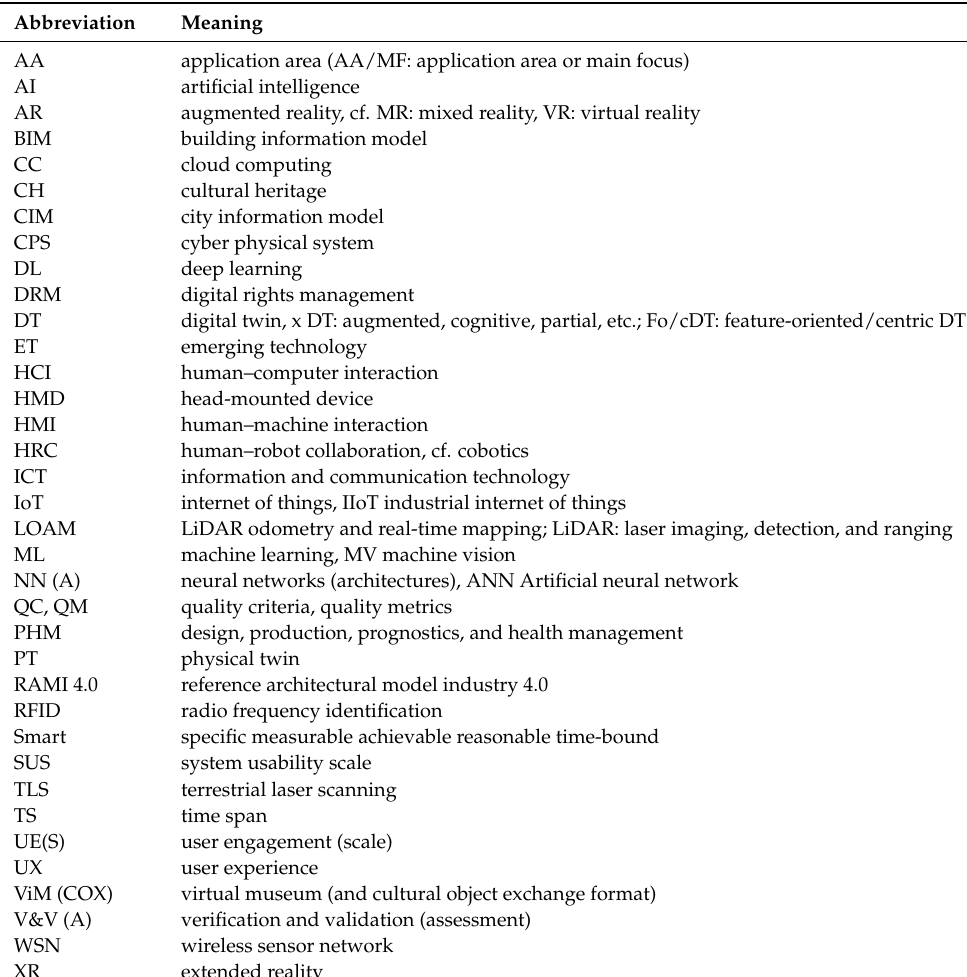
Table A1. Common abbreviations that are used in the text. This list is not